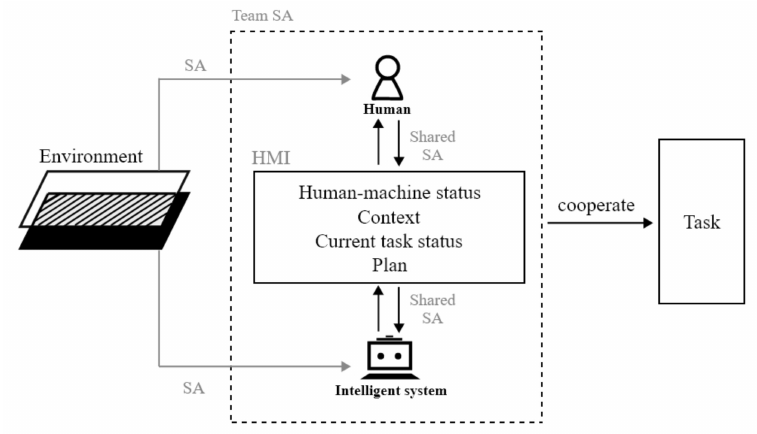
Figure 3. Abstraction Hierarchy of shared situation awareness